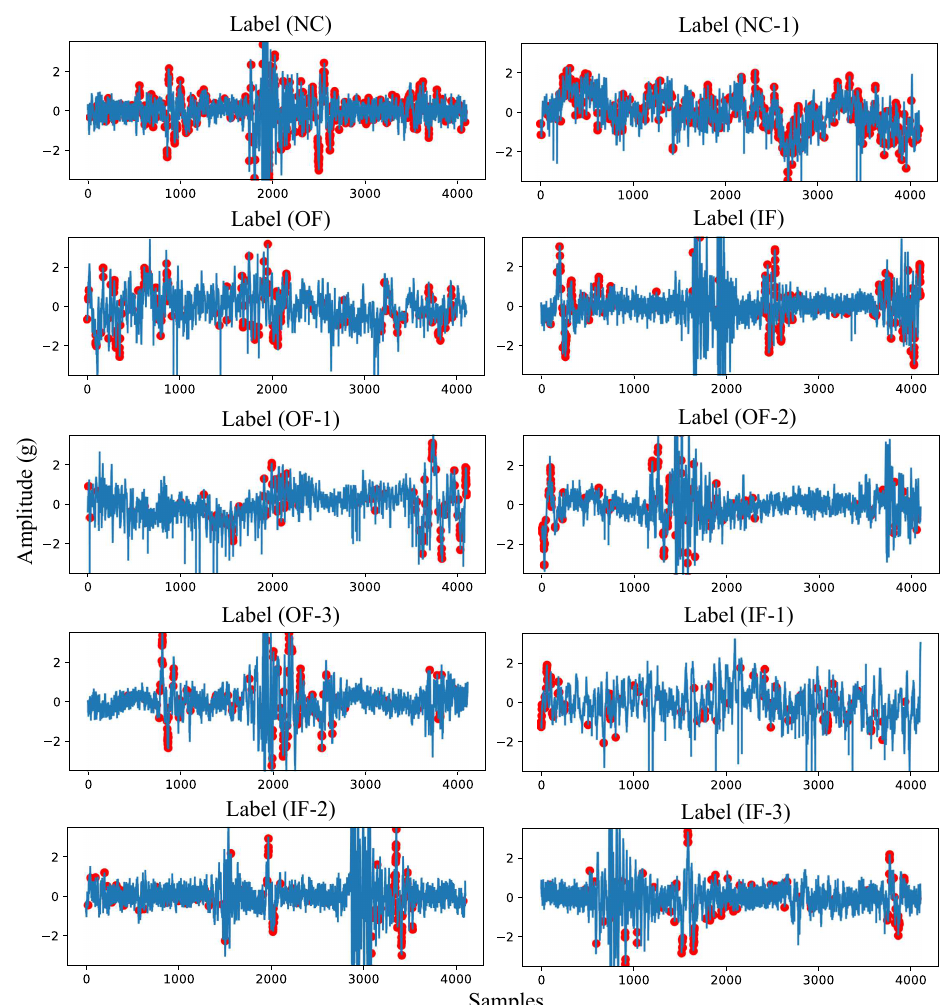
Figure 16. Visualization of the amplitude changes of the bearing vibration